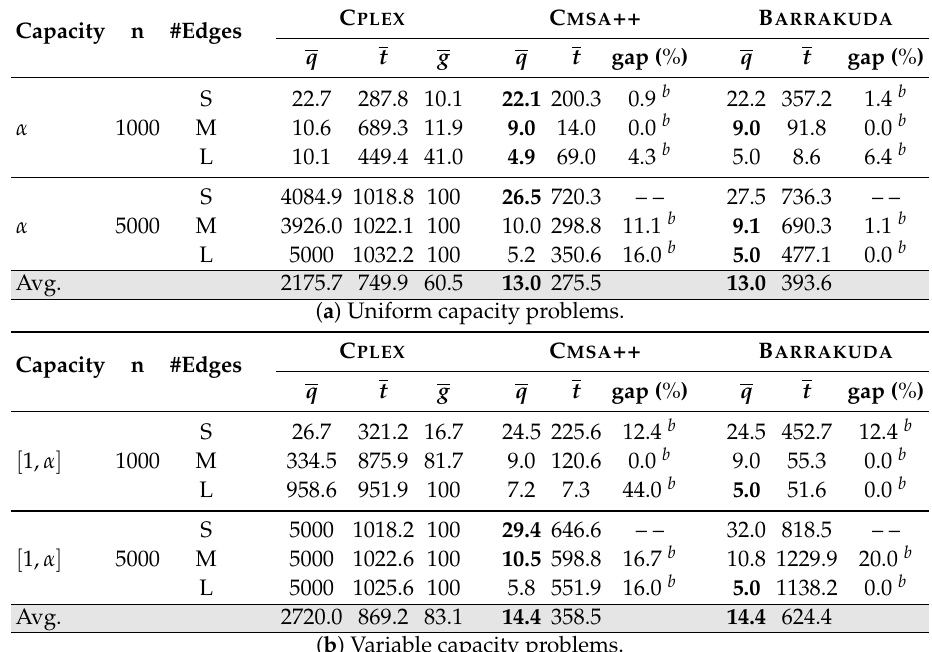
( b ) Variable capacity problems. Experimental results for the random geometric graphs from the new set of large problem